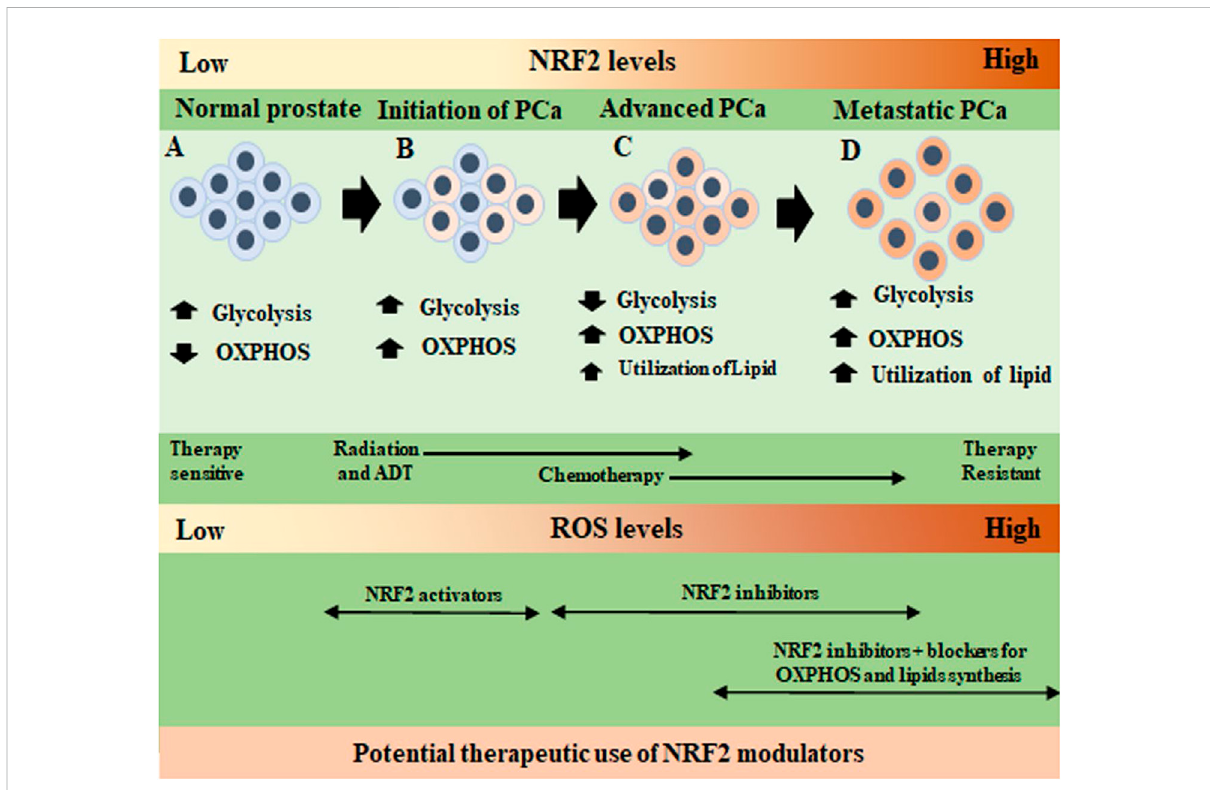
FIGURE 3 Speci fi c regulatory action of NRF2 on metabolic changes in the different stages of prostate cancer progression. (A) . In normal prostate epithelium,NRF2andROSlevelsarelow,andcellsuseglycolysisforenergyproductionwithalowbasallevelofoxidativephosphorylation(OXPHOS). (B) .Intheinitiationofprostatecancer(PCa),cellsslowlyshifttoOXPHOStoproducemostoftherequiredenergy.Glycolysisremainsinalowerlevel. Atthisstage,radiotherapy(RT),andandrogendeprivationtherapy(ADT)begin.BothRTandADTincreaseROStokillthecancercells.Therefore, before RT and ADT, the use of a NRF2 activator may reduce basal ROS levels of the cells and push them to non-transformed mode of metabolism. After initial cell death due to RT and ADT, surviving PCa cells adapt to a high ROS environment and NRF2 levels increase in the PCa cells. (C) .